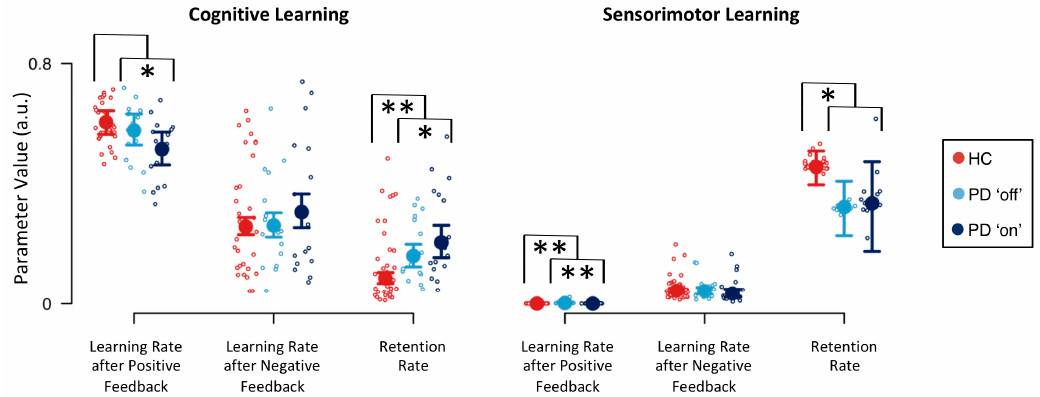
Figure 3. Model parameters for cognitive and sensorimotor learning. Large circles indicate medians of group-level posterior distributions (derived by Equation (A14)). Error bars indicate lower and upper quartiles of group-level posterior distributions. Small circles indicate medians of individual-level posterior distributions (derived by Equation (A13)); a.u. = arbitrary units; * substantial evidence for the presence of an e ff ect; ** strong evidence for the presence of an e ff ect.